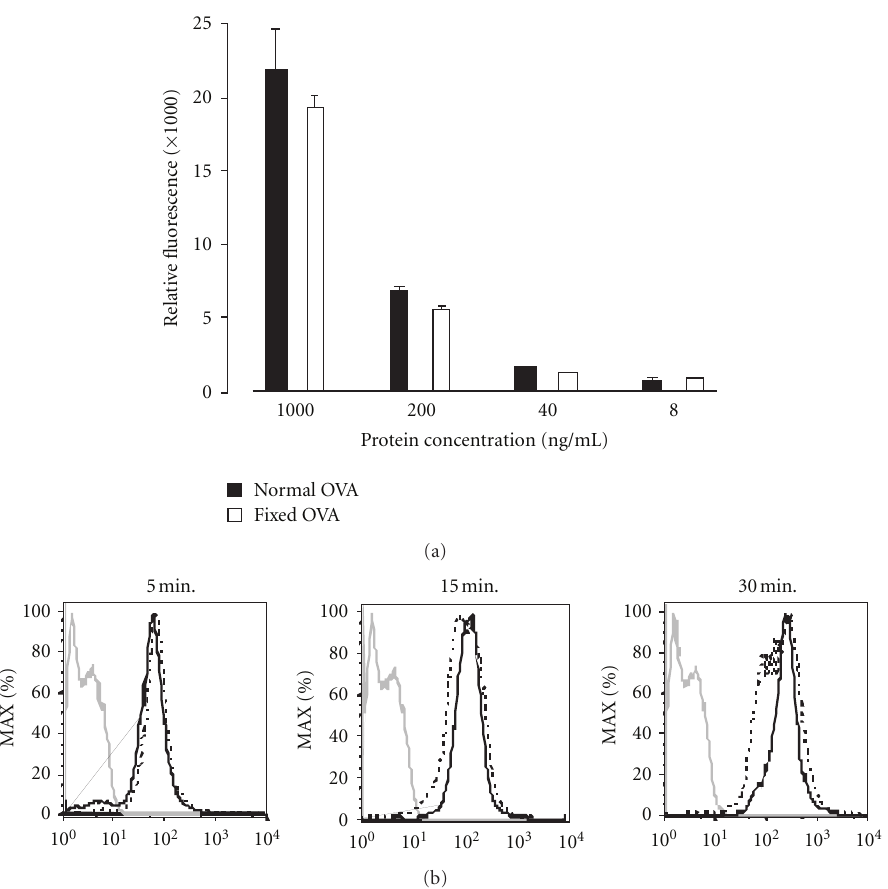
Figure 2: Internalization e ffi ciency by DC2.4cells is comparable between native and fixed OVA. (a) Labeling-e ffi ciency with AF647 was equal between native and fixed OVA. Native and fixed-OVA were labeled with AF647 and graded doses were analyzed for their relative fluorescence incorporation. (b) DC2.4cells were incubated with 1mg/mL AF647-labeled native OVA or fixed OVA for the indicated times and internalization was analyzed by flow cytometer. (----): native OVA, (—): fixed OVA. Gray line: unpulsed DC2.4cells. Note: MFI = 114 (5min), 159 (10min), and 306 (15min) with normal OVA and 77.3 (5min), 160 (10min), and 310 (15min) with fixed OVA. The results were confirmed in two independent experiments.